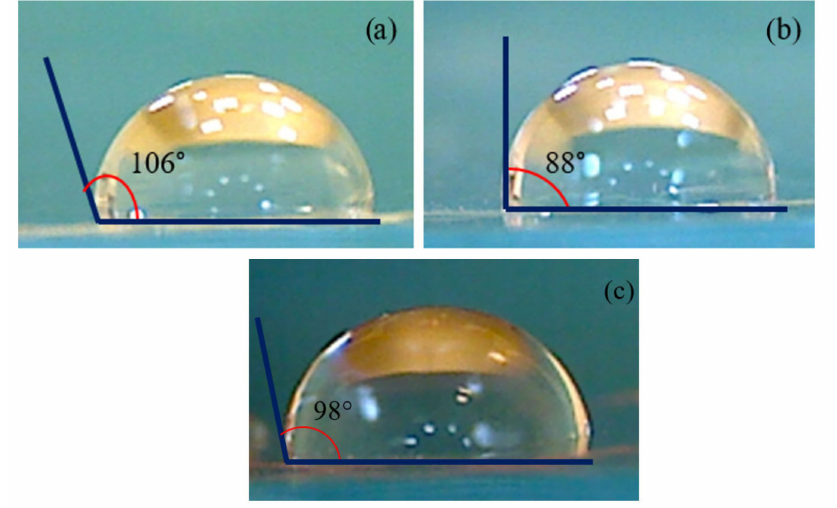
Figure 9. Contact angle for virgin COC ( a ), for COC deposited with Al ions ( b ), and for COC deposited and then immersed in acetone ( c